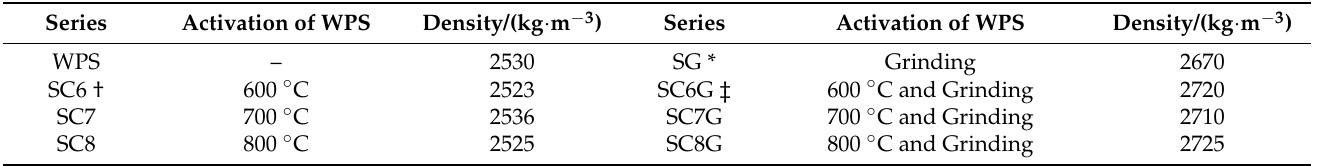
Table 1. The labeling for various activated WPS samples.